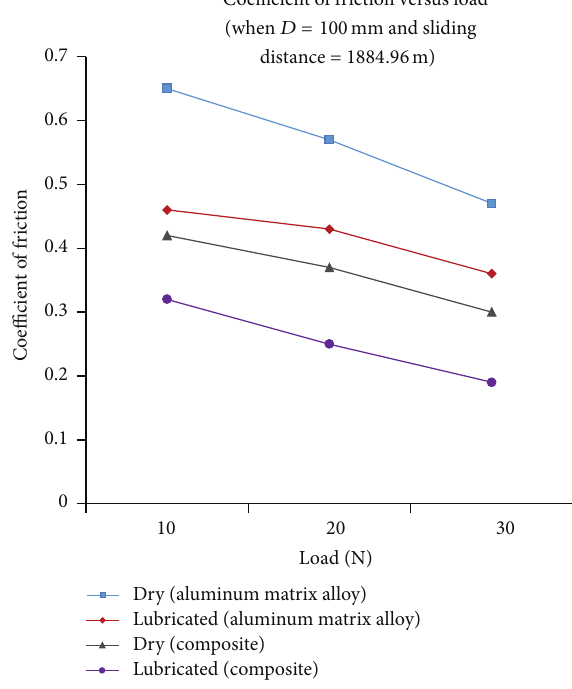
Figure 2: Variation of COF at 𝑉 = 3.14